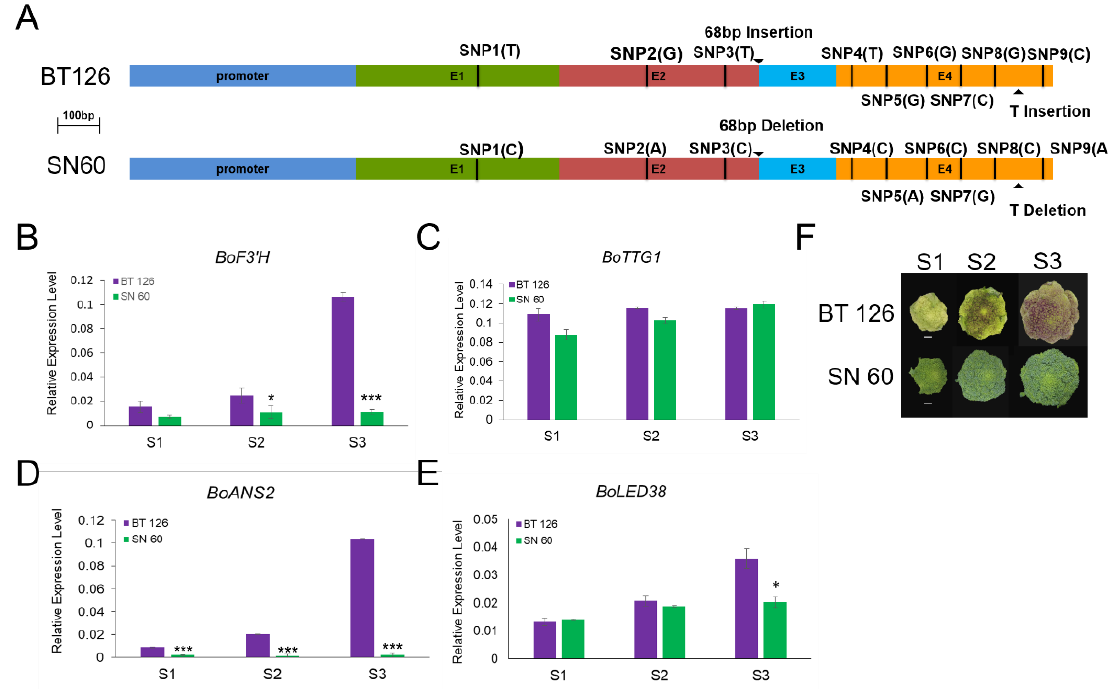
Figure 4. Structure identity and expression of broccoli gene BoF3’H . ( A ) Comparison of BoF3’H promoter and cDNA sequence between parental lines BT 126 and SN 60; ( B – E ) relative expression of BoF3’H , BoTTG1 , BoANS2 , and BoLED38 at three head developmental stages. Significant differences between BT 126 and SN 60 are indicated by * based on Students t test (* p < 0.05, ** p < 0.01; *** p < 0.001); ( F ) the phenotype of the head during three developmental stages. The upper part depicts the head of BT 126, while the lower part depicts the head of SN 60. Scale bar = 1cm.